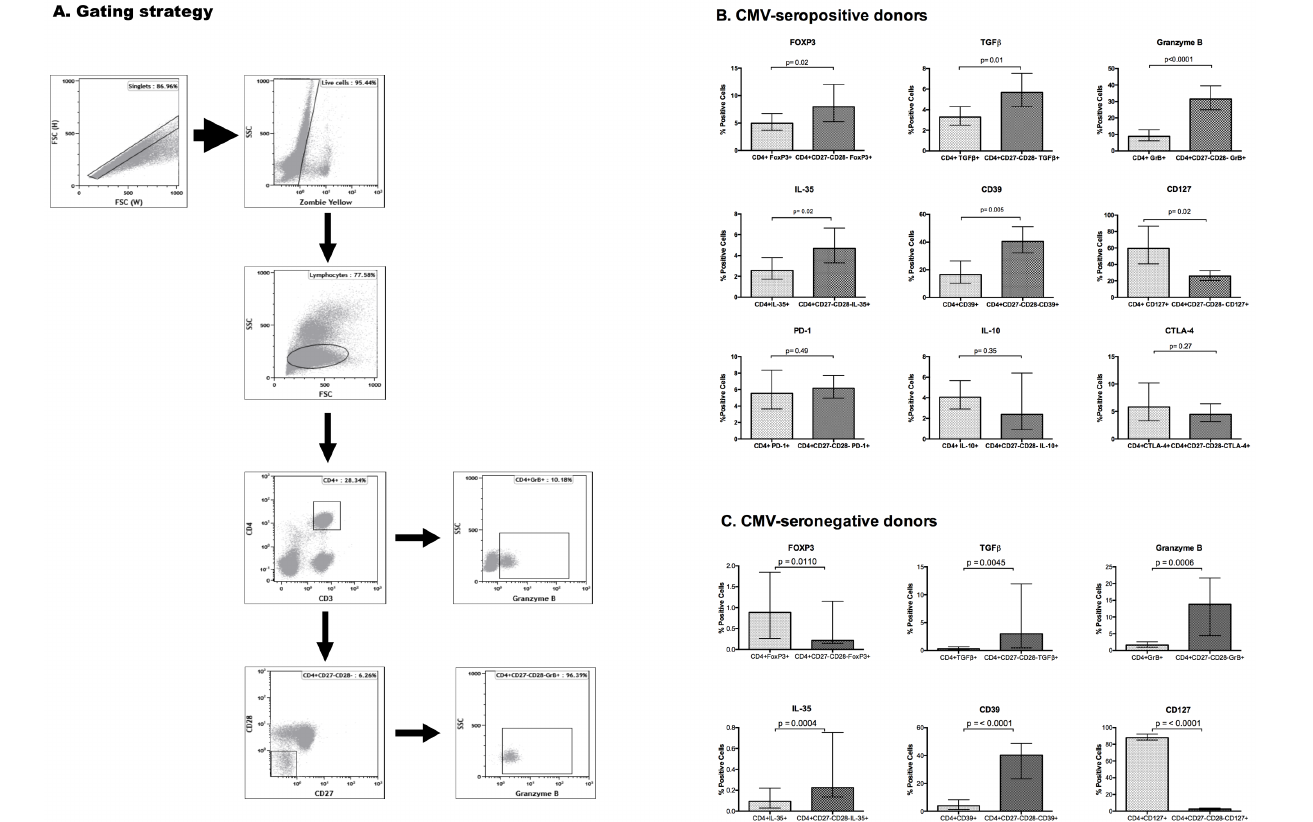
Fig 2. Phenotypic characterization of peripheral blood CD4+CD27-CD28- T cells of CMV-seropositive donors (B) and CMV- seronegative donors (C). Panel A shows the gating strategy. For panels B and C the data for each marker were derivedfrom 7 to 20 CMV- seropositive or CMV-seronegativeindividuals per marker. The bars represent geometric means and 95% confidenceintervals of the frequency of each marker in the entire CD4+ T cell population(light bars) and in the CD4+CD27-CD28- T cells only (dark bars). The marker studiedis indicatedin the title of each graph. P values were calculatedby pairedStudent’s t test using log-transformed values.